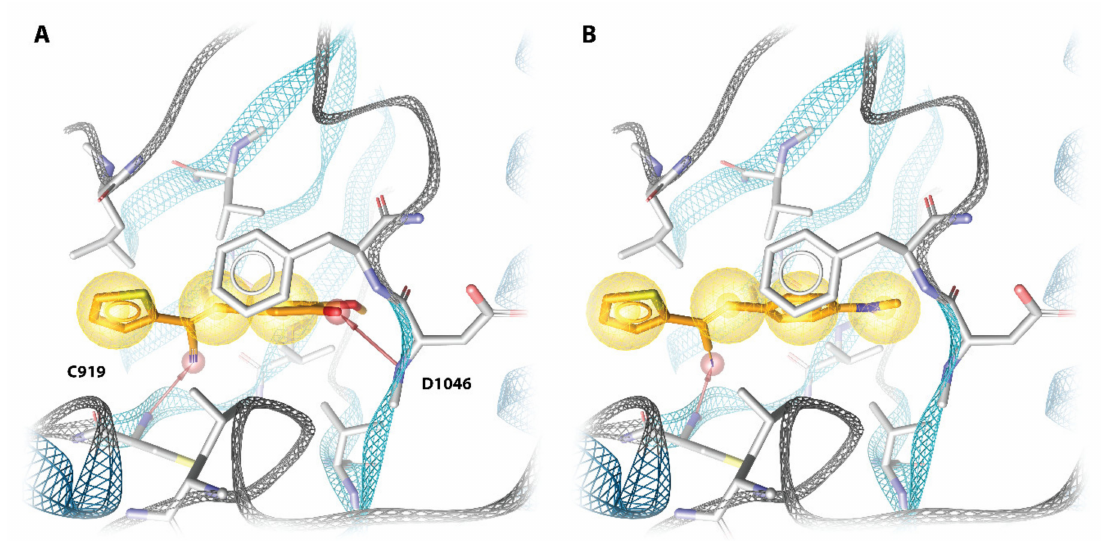
Figure 6. Identified binding mode of ( A ) compound 1c and ( B ) compound 1b against human VEGFR-2 structure 3VHE. The protein cartoon representation is colored light blue for beta-sheets, dark blue for helices, and grey for loop structures. Ligands are depicted as sticks with carbon atoms colored in orange. Highlighted protein residues are involved in interactions with both compounds and are depicted as sticks with white carbon atoms. Red arrows, hydrogen bond acceptors; yellow spheres, hydrophobic